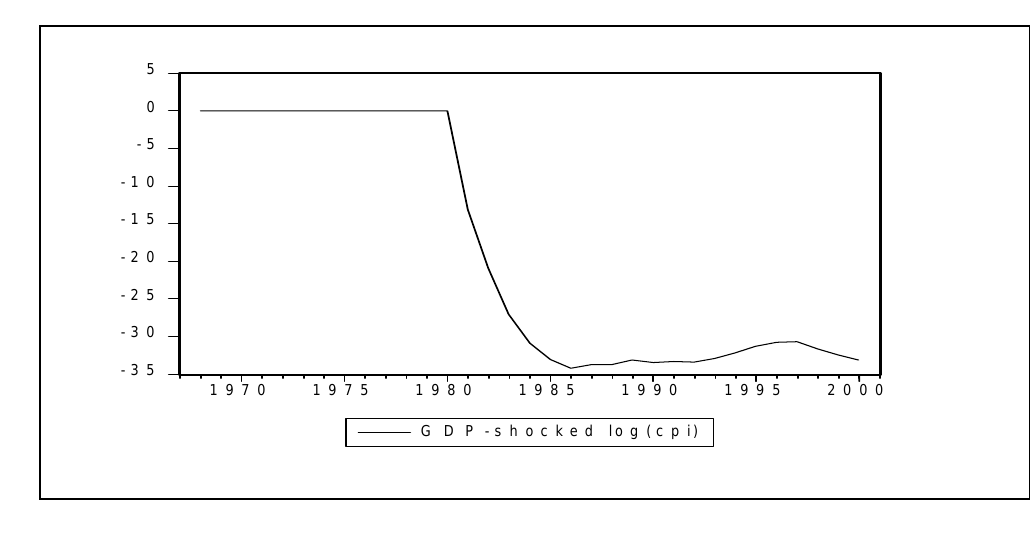
Figure 3 Dynamic adjustment properties on CPI due to a 10 per cent increase in the